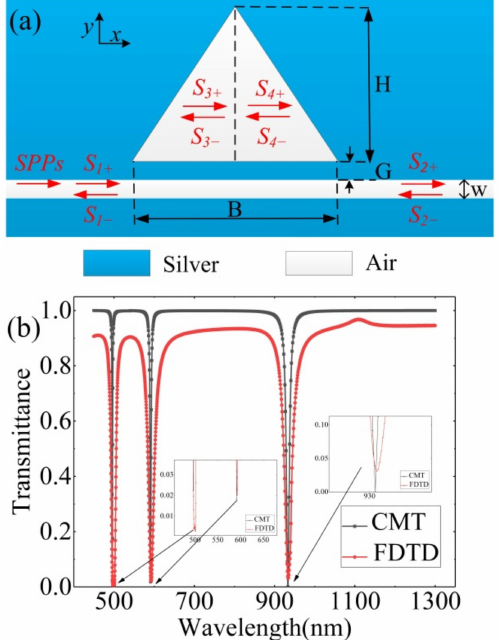
Figure 1. ( a ) The schematic of the equilateral triangle-shaped cavity (ETSC); ( b ) the transmission spectra of the ETSC by using coupled mode theory (CMT) and Johnson and Christy